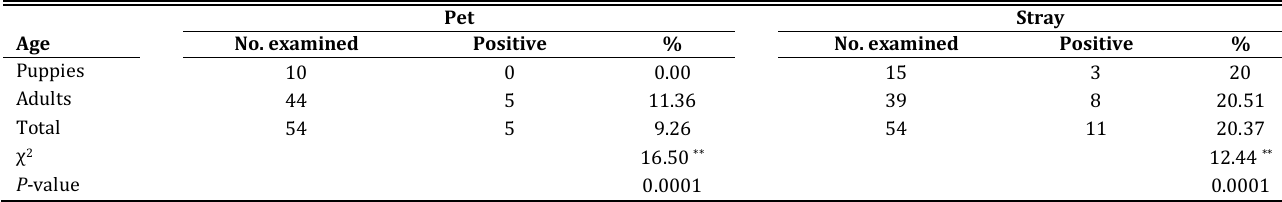
Table 4 . Dipylidium caninum infection rates in pet and stray dogs according to the age